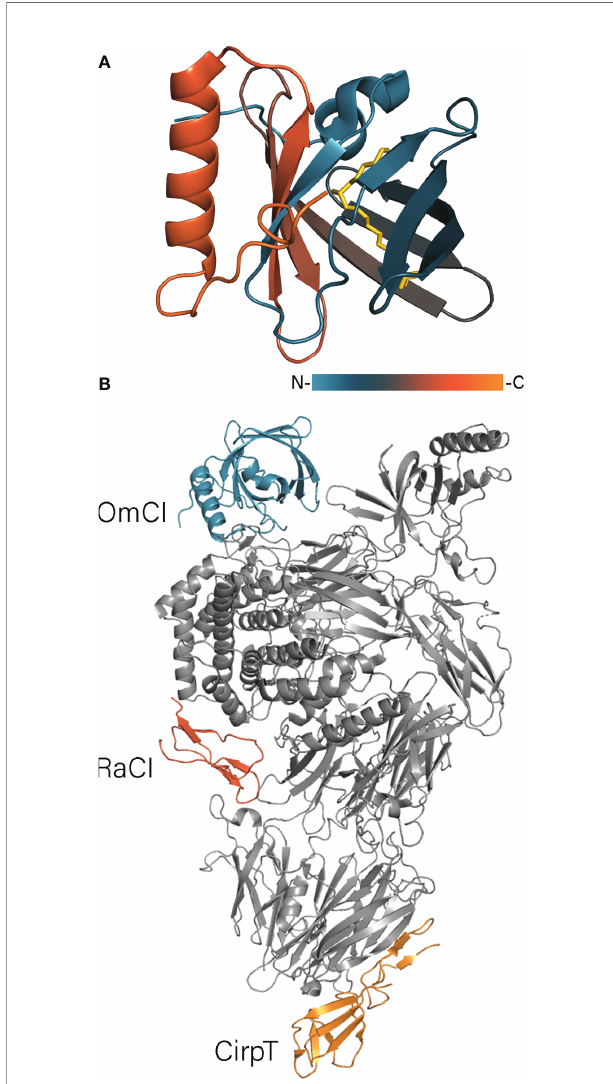
FIGURE 3 | (A) OmCI structure in the complex with ricinoleic acid (PDB: 2CM4). OmCI structure is colored according to a gradient, ricinoleic acids is shown in yellow. (B) The structure of C5 protein in the complex with OmCi, RaCI, and CirpT (PDB: 6RQJ). C5 is shown in grey, tick proteins – in